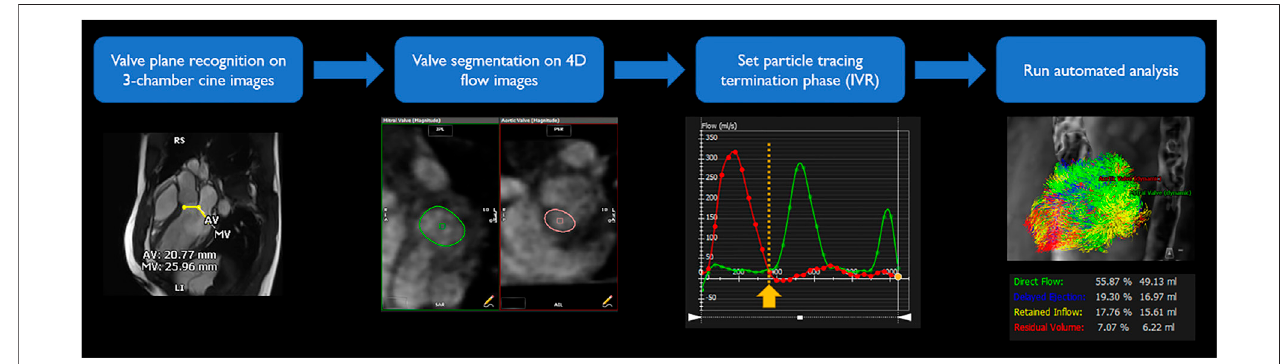
FIGURE 2 | LV fl ow component analysis work fl ow. To obtain segmentation of entrance and exit of the LV, valve plane was recognized on three-chamber cine images. Exact shape of the valves was segmented on 4-D fl ow images for each time frame. Iso-volumetric relaxation phase was identi fi ed from time- fl ow graph, minimizing both fl ows through the valves. From and to the selected phase, automated simulation traced particles and divided into four